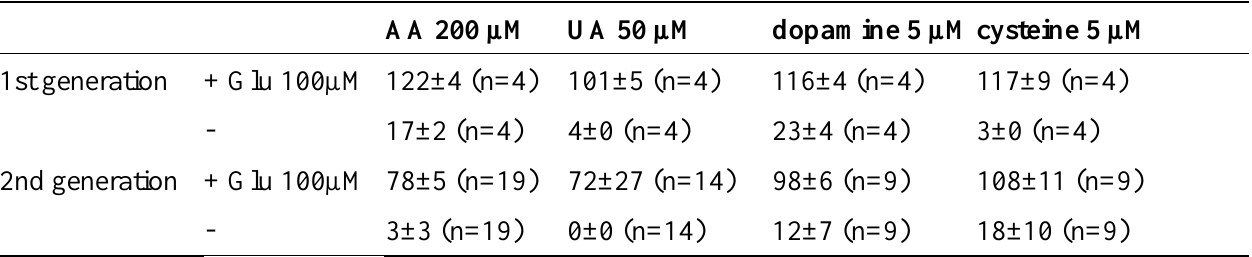
Table 2. Selectivity of both generations of sensors. The values were expressed as percentage of the current generated with 100 µM